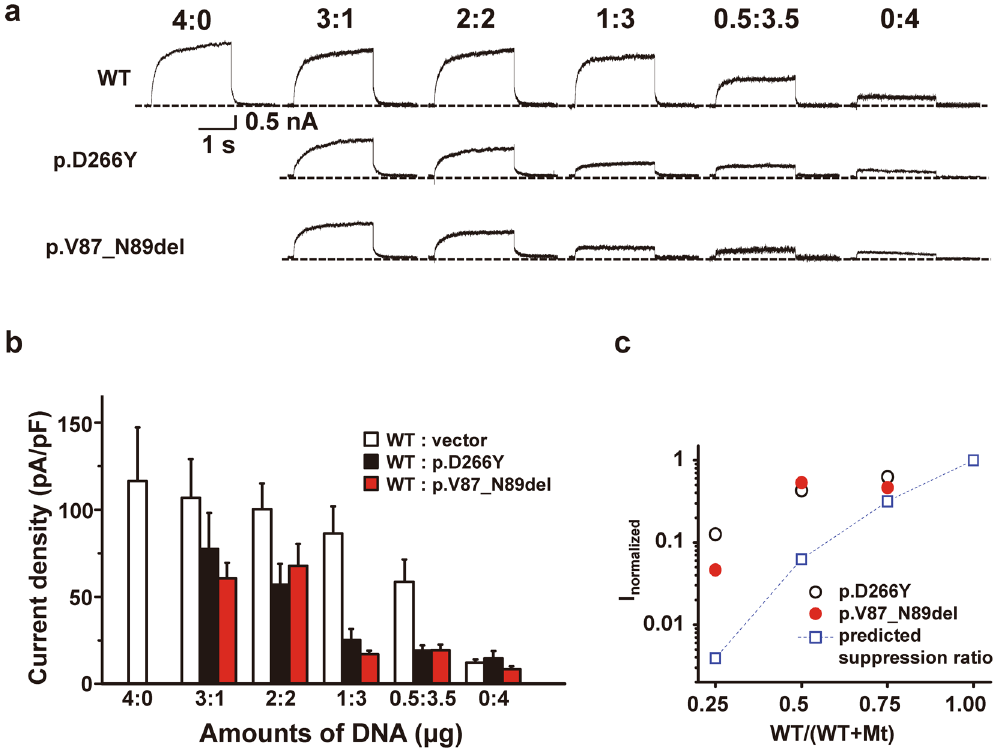
Figure 4. Dominant-negative effects of the mutant KCNQ4 channels. ( a ) Individual mutants (p.D266Y and p.V87_N89del) were co-expressed with WT KCNQ4 at the indicated WT:mutant cDNA molar ratios, and linopirdine-sensitive K + current traces were recorded at + 40 mV. Dashed lines indicate zero current levels. ( b ) Comparison of current densities at + 40 mV. WT:mutant cDNA ratios are indicated under the bar graphs, and the total amount of cDNA was equalized in all groups by adding empty vector (pRK5). ( c ) Suppression of WT-mediated current by the co-expression of mutant (Mt) KCNQ4 channels. The mean values of the current densities obtained at + 40 mV were normalized, and the current suppression ratios were denoted against WT/(WT + mutant) ratios of cDNA transfected. Dashed line with a square symbol denotes the predicted suppression ratio expected for the tetrameric channel. Mean ± SEMs (n =